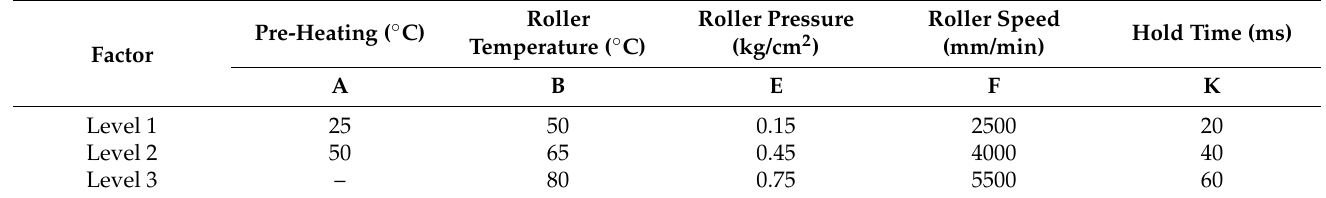
Table 8. Control factors and their corresponding levels for the L 18 (2 1 × 3 7 ) experiment.